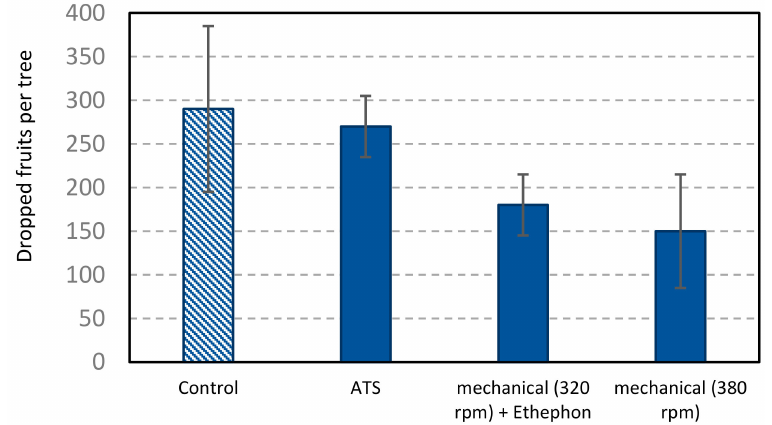
Figure 3. E ff ect of crop load management (CLM) on fruit drop of the European plum cv. “Ortenauer” in Bonn, Germany, in 2013; error bars represent SDs at the 5% error level.